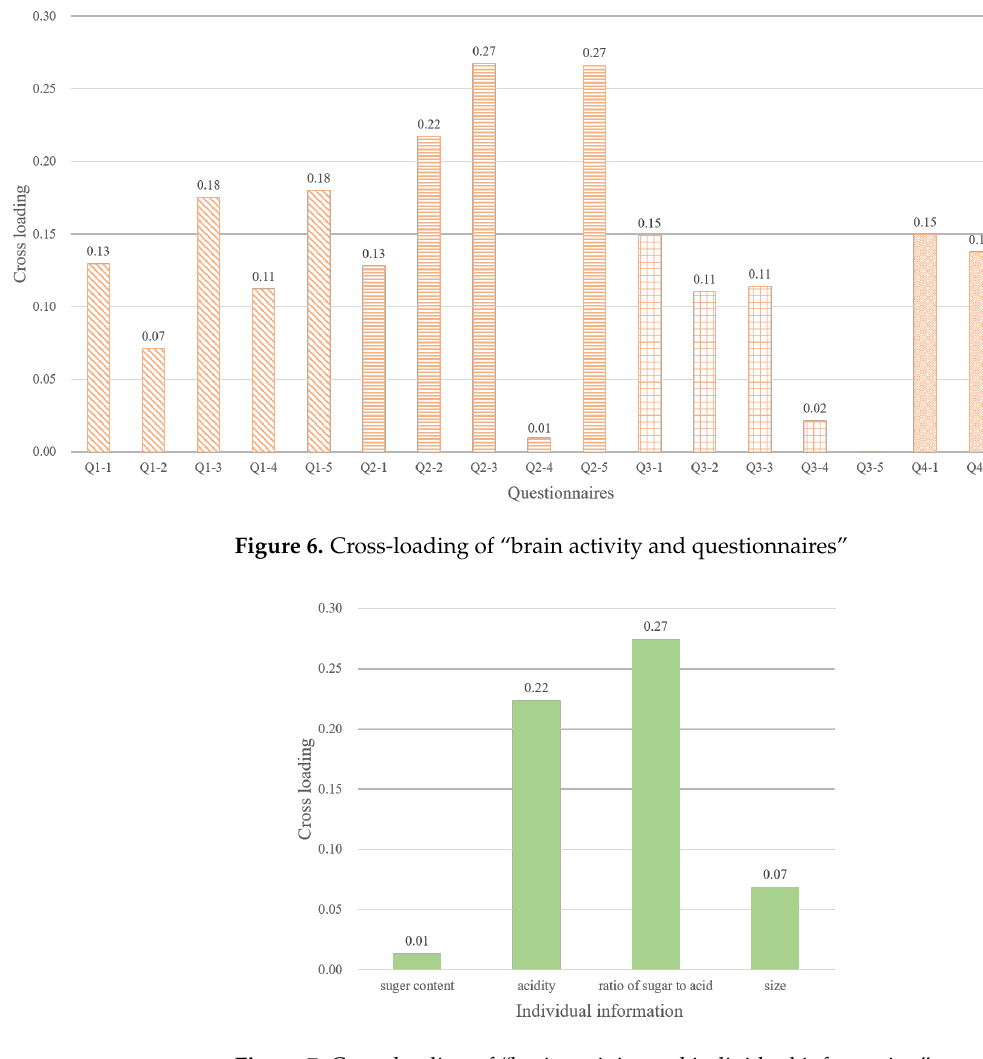
Figure 7. Cross-loading of “brain activity and individual